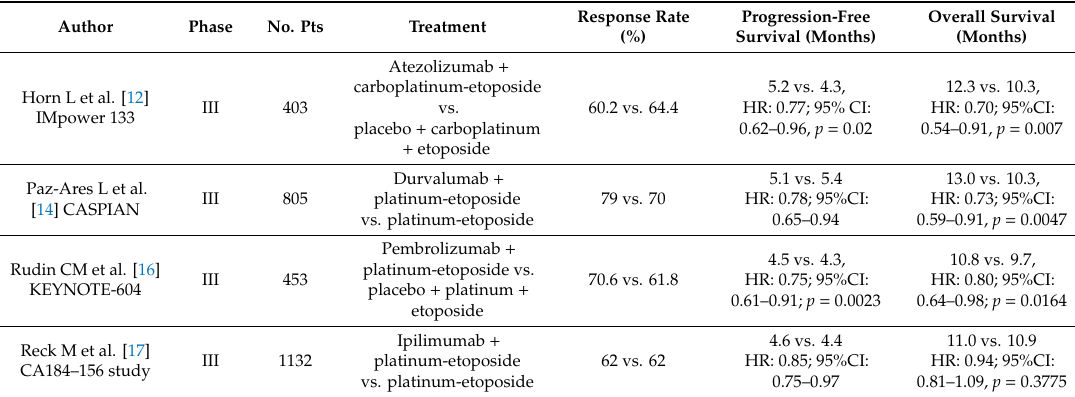
Table 1. First line immunotherapy in